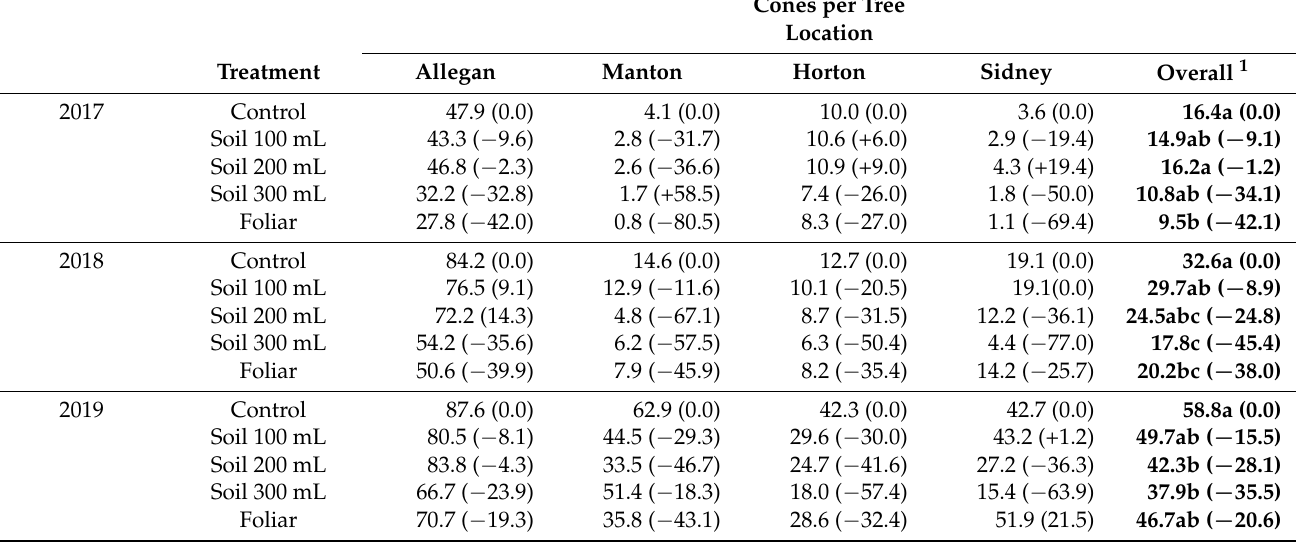
Table 1. Mean cone density of Fraser fir trees treated with soil injected or foliar applied paclobutrazol. Soil treatments were applied in 2016. Foliar treatments were applied annually 2016–2018. Figures in parentheses indicate change in means relative to untreated